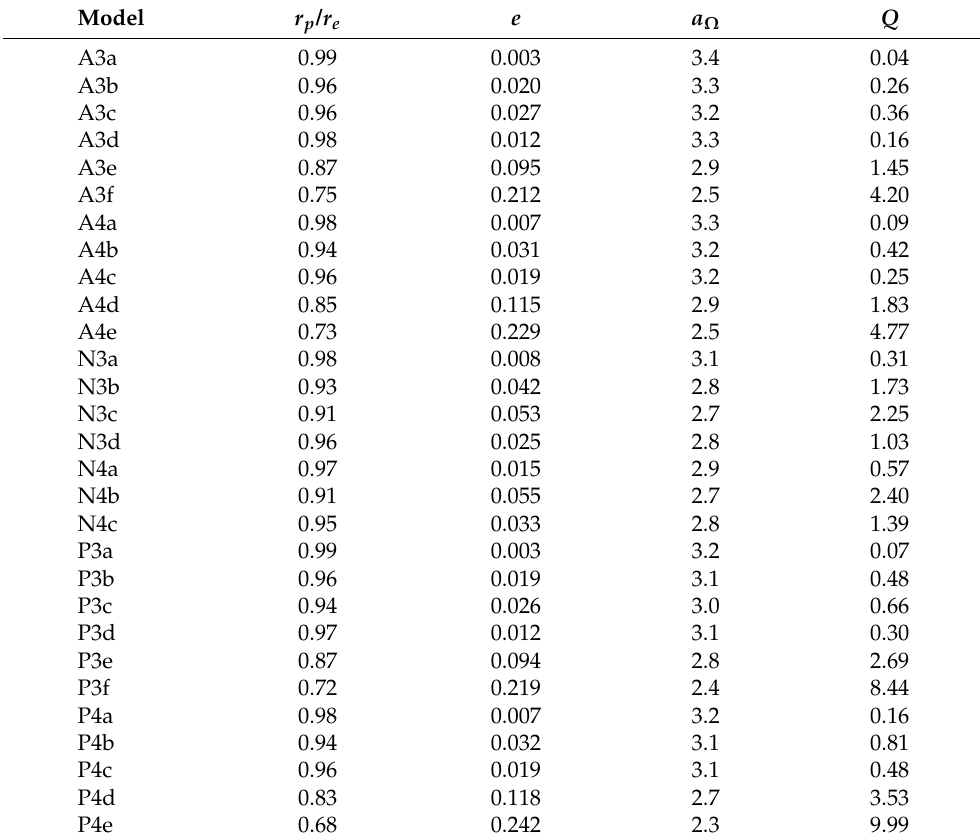
Table 2. Polar-to-equatorial ratio r p / r e , Newtonian quadrupole deformation e -defined by Equa- tion (12), distortion coefficient a Ω -defined by Equation (14) and metric quadrupole Q -defined by Equation (13), for all models in Table